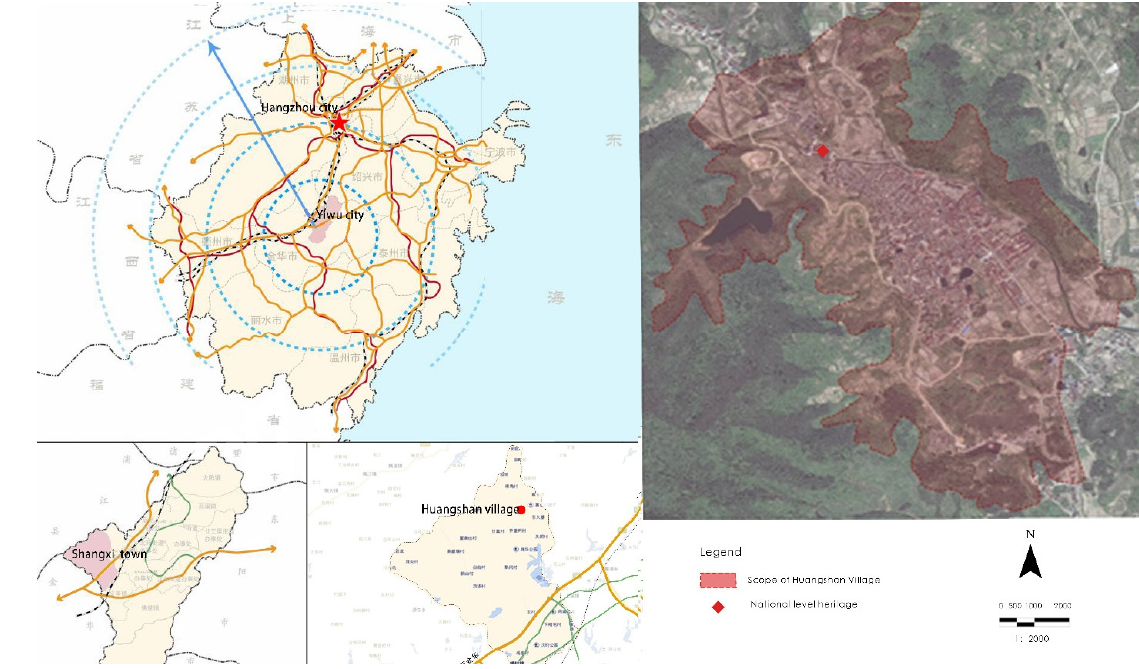
Figure 1. The location and territory of Huangshan traditional village.